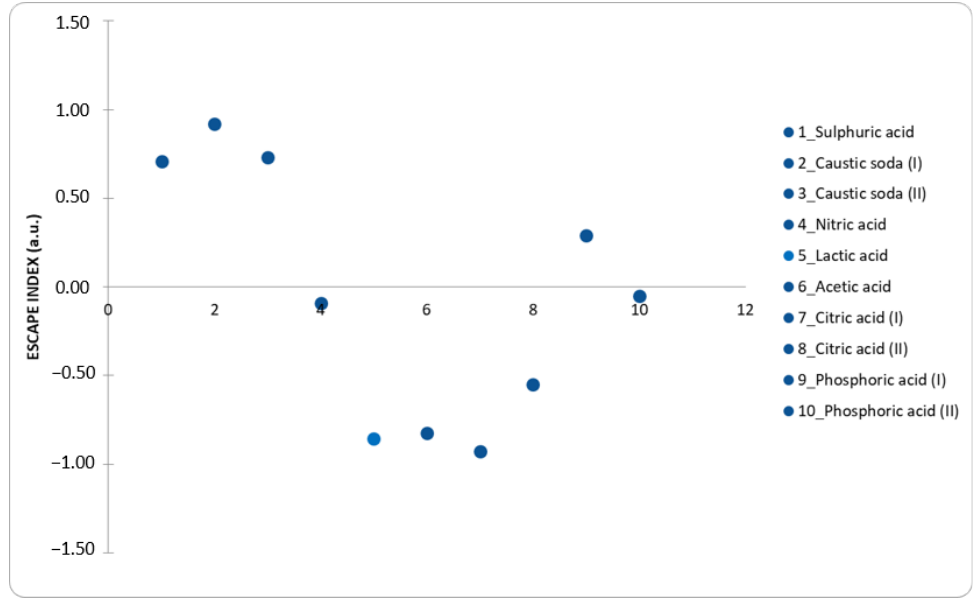
Figure 4. ESCAPE index values of 10 processes with related leaching agents, reported in Table 1.